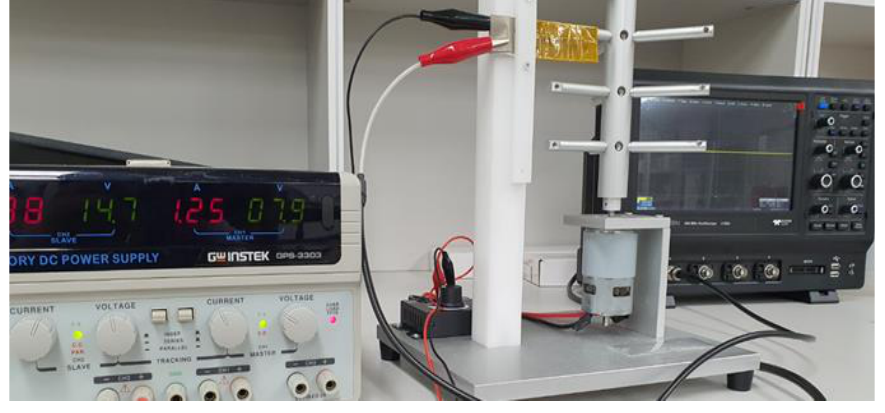
Figure 9. A picture of hitting machine setup.